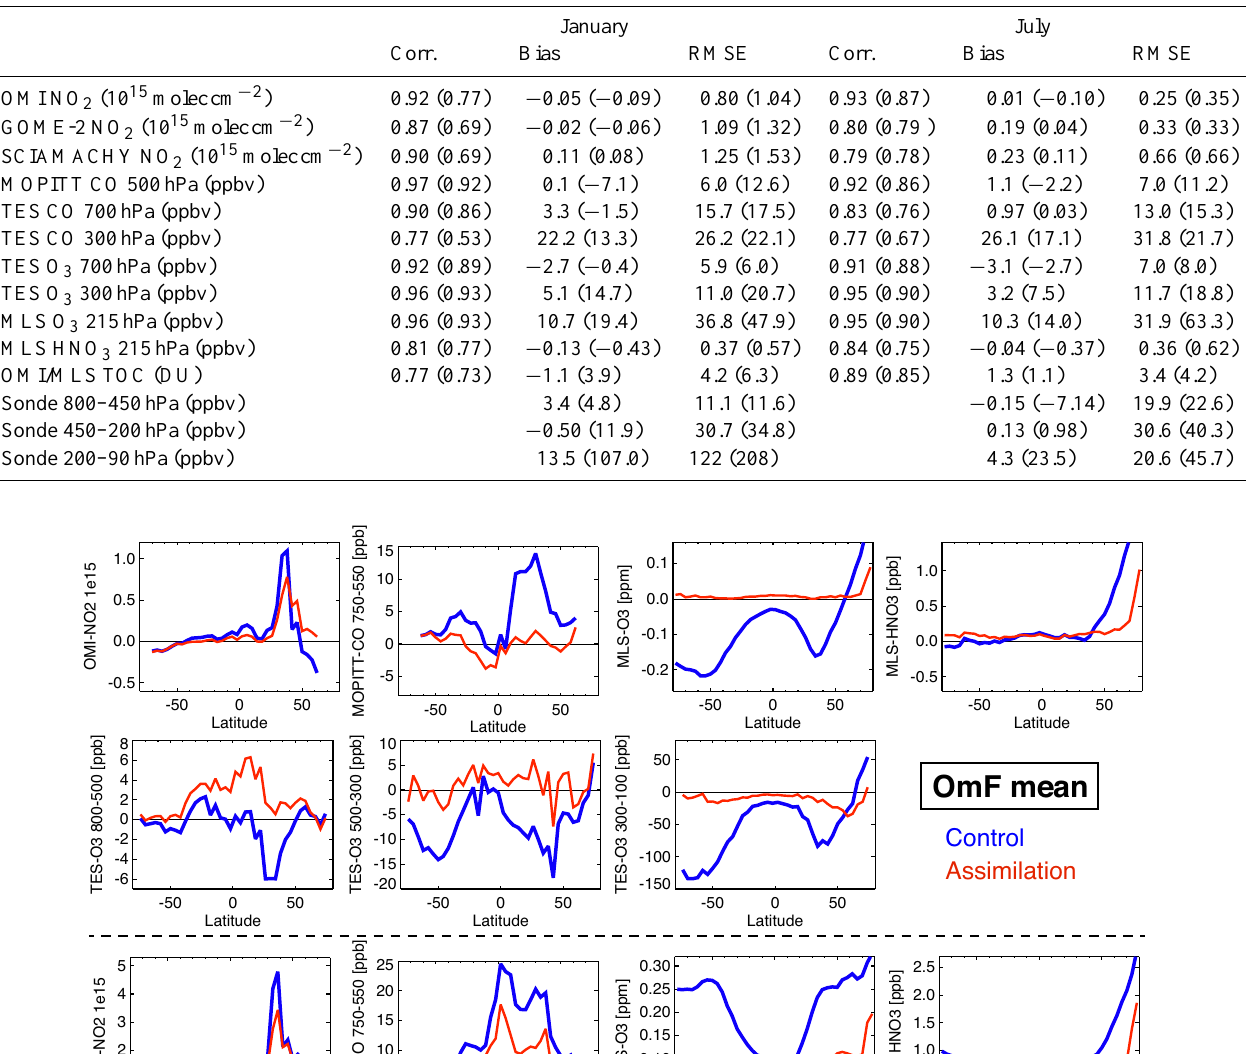
Table 5. Comparisons between the data assimilation run and the satellite retrievals. The results are obtained from 15-day averages (from the 16–30 of each month) for January and July in 2007. Shown are the global spatial correlation (Corr), the global mean difference (Bias), and the global root-mean-square error (RMSE). The model simulation results (without data assimilation) are shown in brackets.